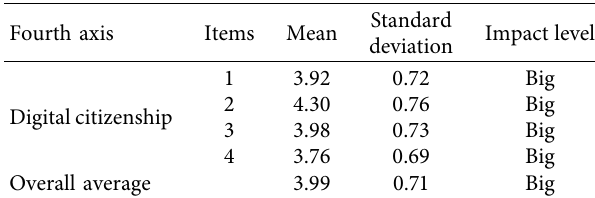
Table 6: Arithmetic averages and standard deviations of the fourth axis. Fourth axis